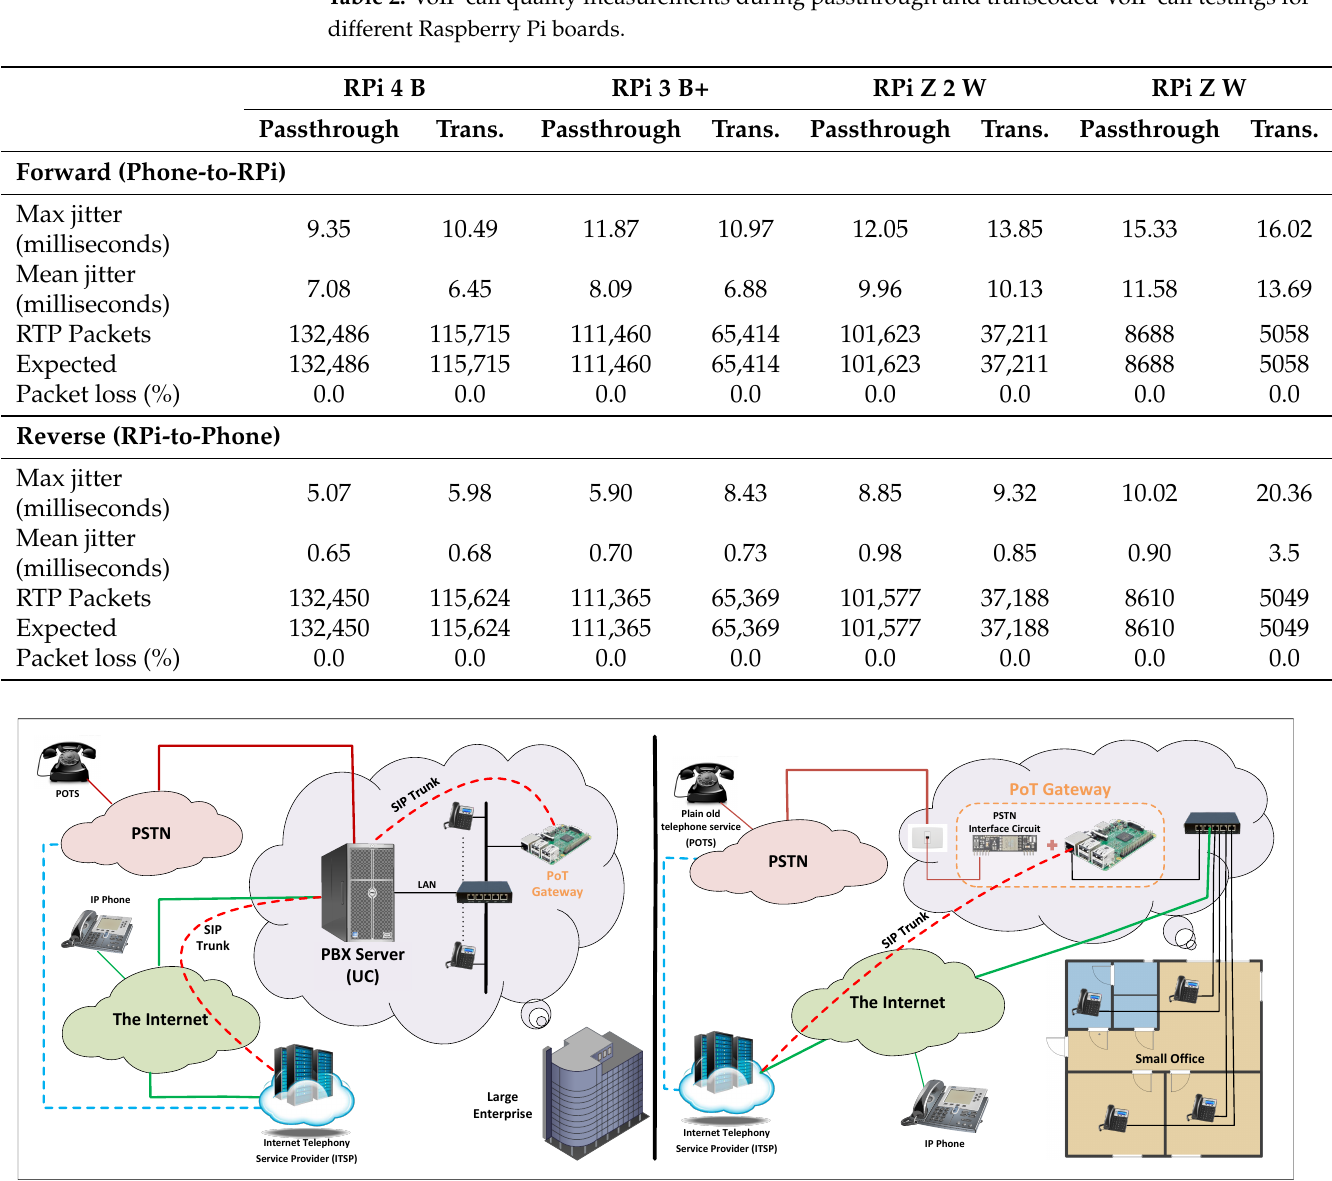
Figure 14. LTC implementation scenarios: a small office and a large